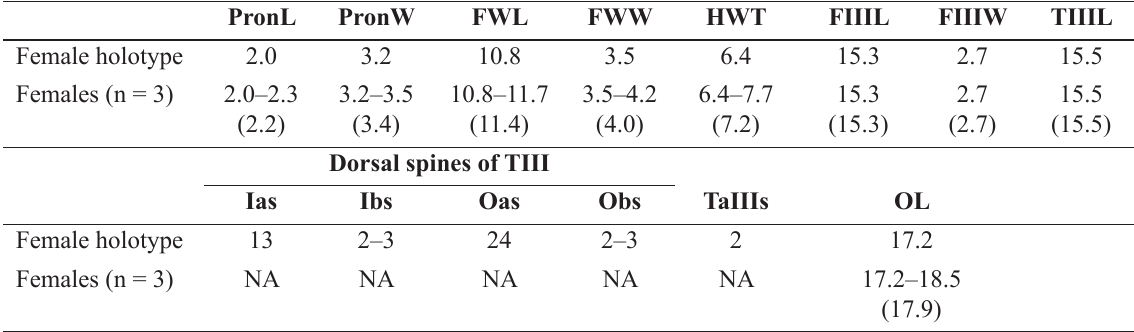
Table 5. Measurements of Nisitrus danum Robillard & Tan sp. nov. (in mm, means in